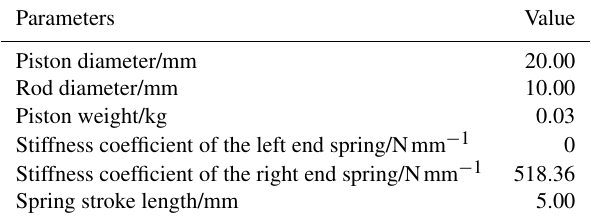
Table 1. Simulation parameters of displacement regulator.